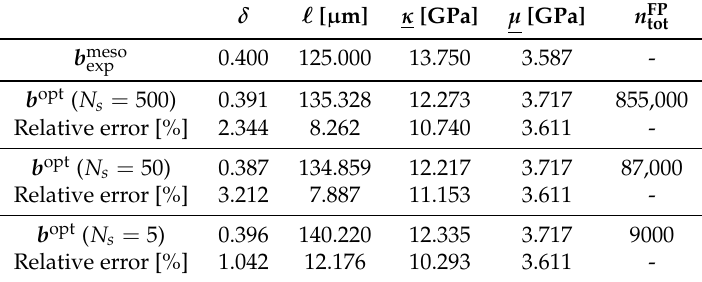
Table 3. Fixed-point iterative algorithm: comparison between the global optimal value b opt and the reference experimental value b meso exp for different values of the number N s of independent realizations generated for the statistical estimation of the mathematical expectations involved in the different numerical